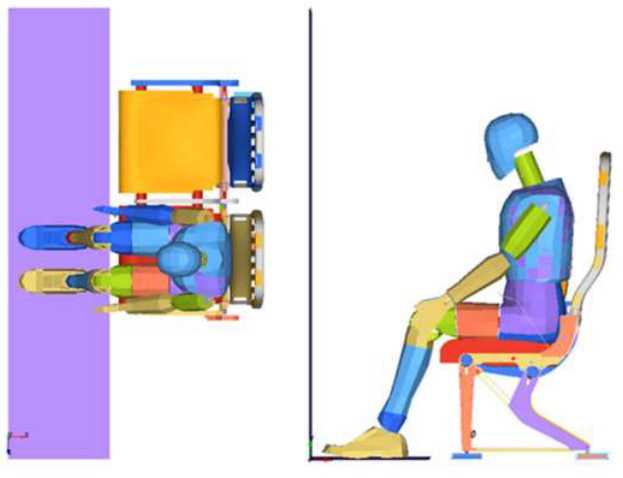
Figure 4. Finite Element (FE) model.